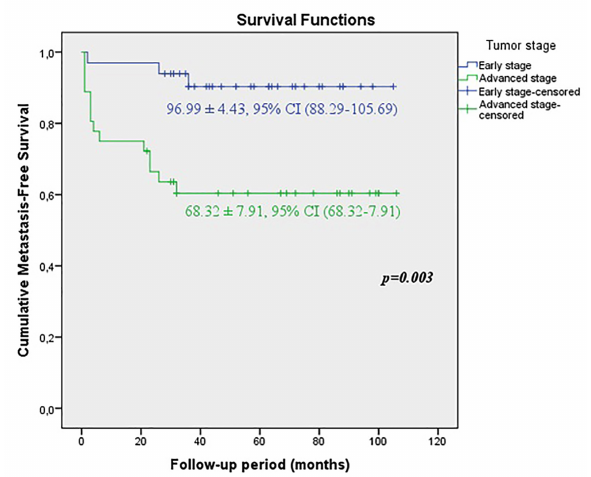
Figure 1C - Kaplan-Meier plots of metastasis-free survival according to the early and advanced stages for all tumors.